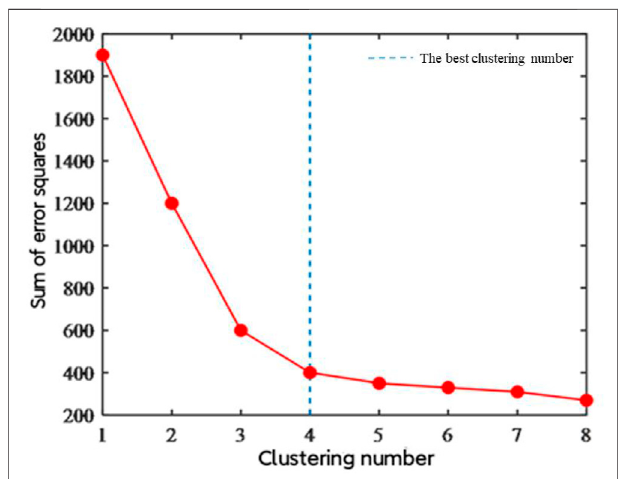
FIGURE 5 | Determining the best cluster number by the Elbow method.